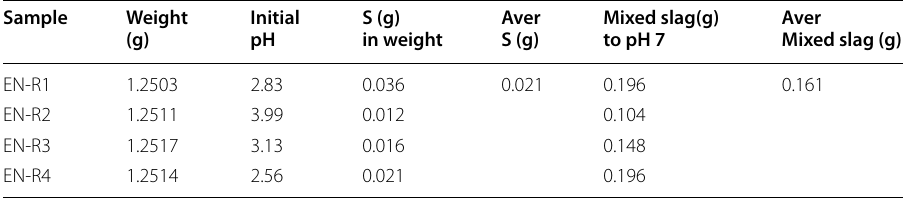
Table 2 Required mixed slag amount by sulfur Sample Weight